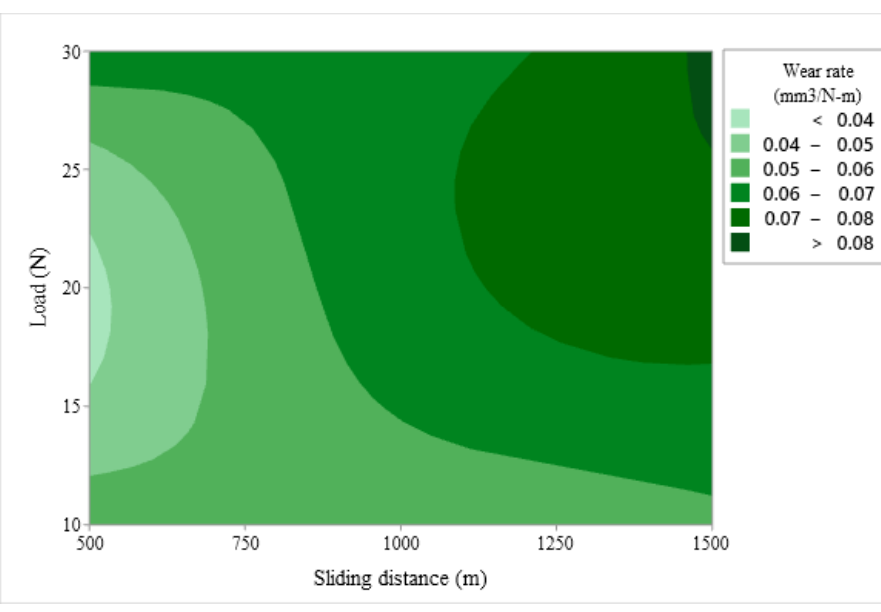
Fig. 7. Contour plots for wear rate vs. load and sliding distance.